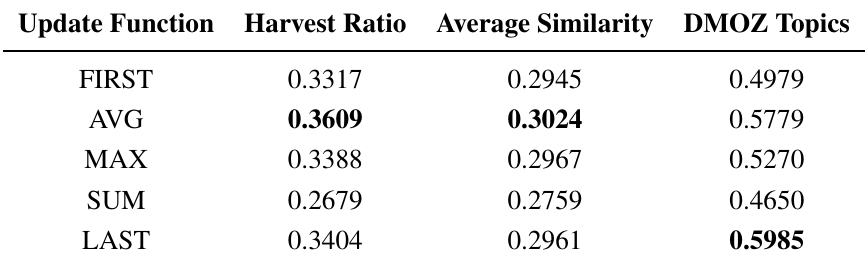
Table 1. Results of simulated adaptive